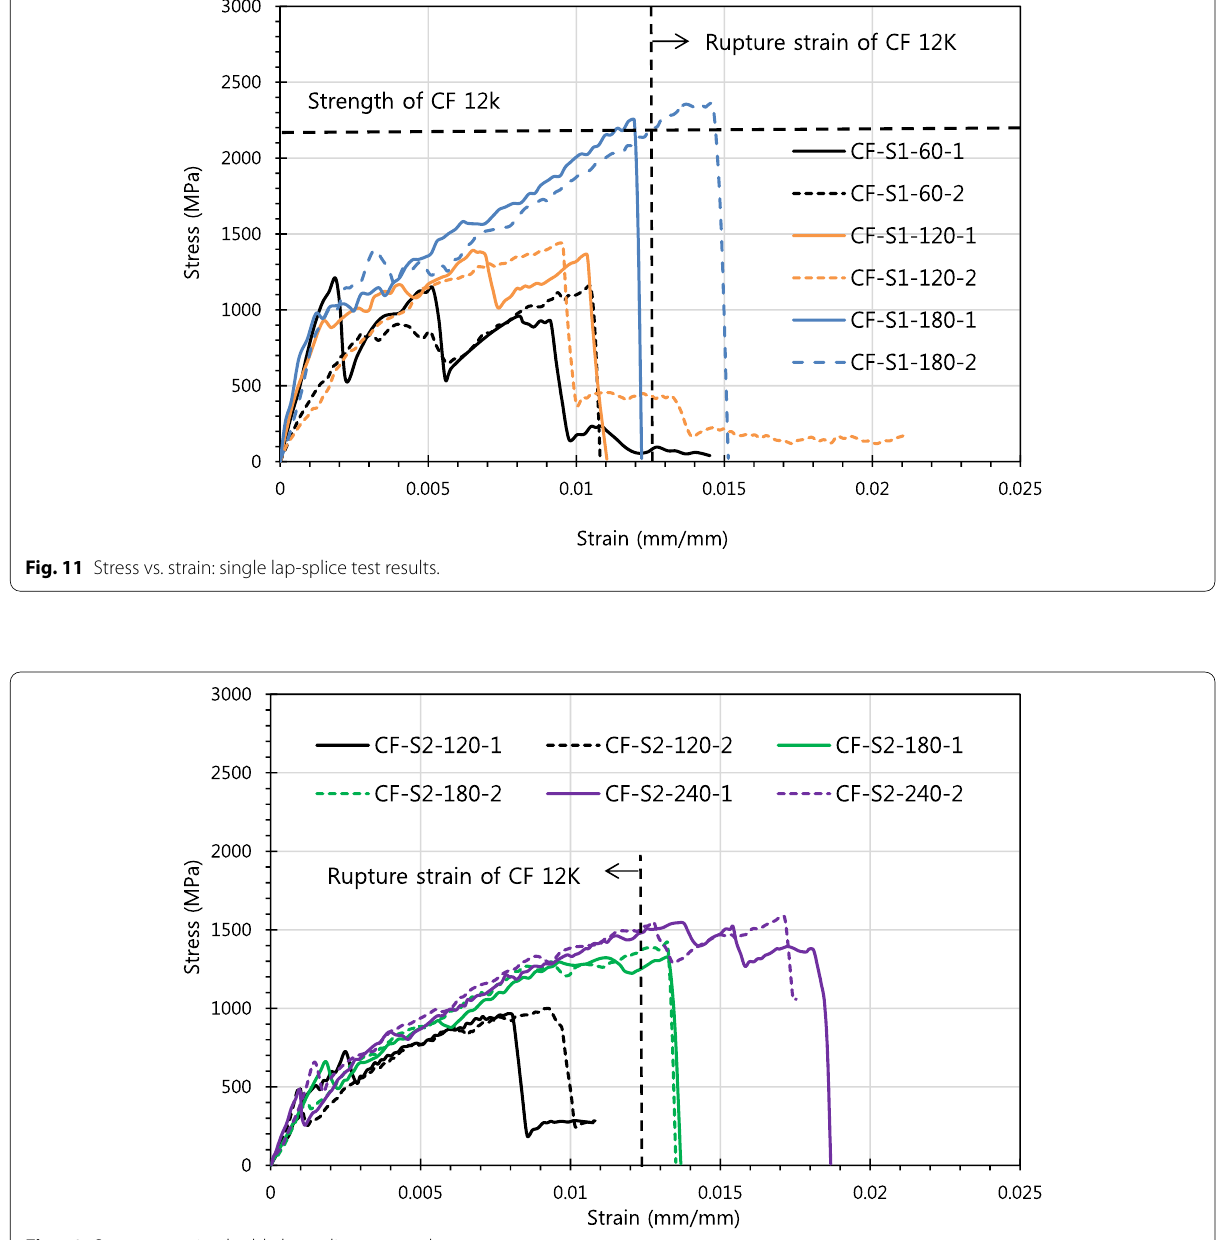
Fig. 12 Stress vs. strain: double lap-splice test